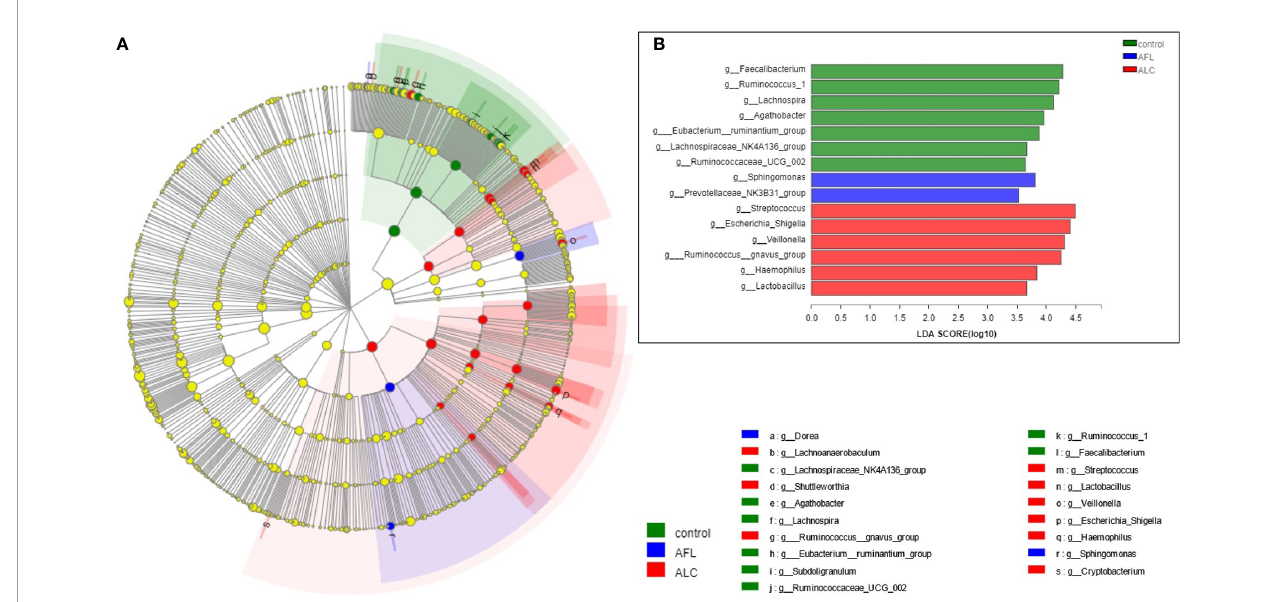
FIGURE 3 | Microbial taxa identi fi ed in different groups using LEfSe analysis. (A) Cladogram showed the phylogenetic distribution of bacteria that were signi fi cantly enriched between the three groups. Different colors spots represent signi fi cantly enriched bacterial in the corresponding group. (B) LDA scores showed signi fi cant differences in bacterial within groups at the genus